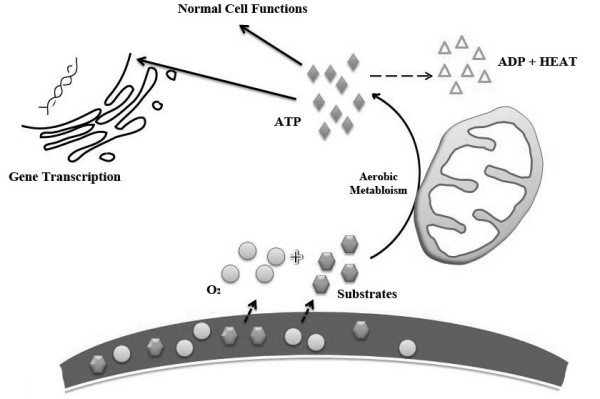
Aerobic metabolism in the cell guarantees adequate ATP for normal physiologic function and heat production (thermoregulation). ATP = Adenosine Tri-Phosphate. ADP = Adenosine Di-Phosphate.